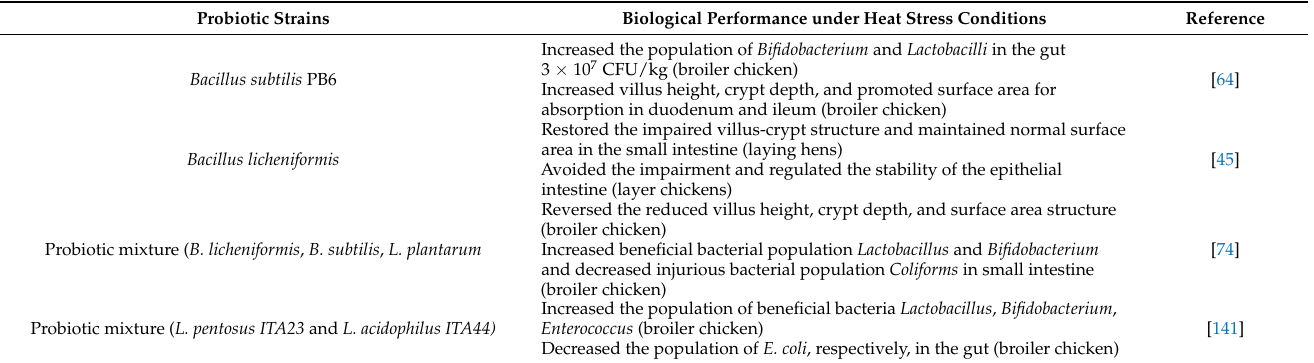
Table 2. Example of different types of probiotics and their application in poultry to ameliorate intestinal morphology under heat-stressed